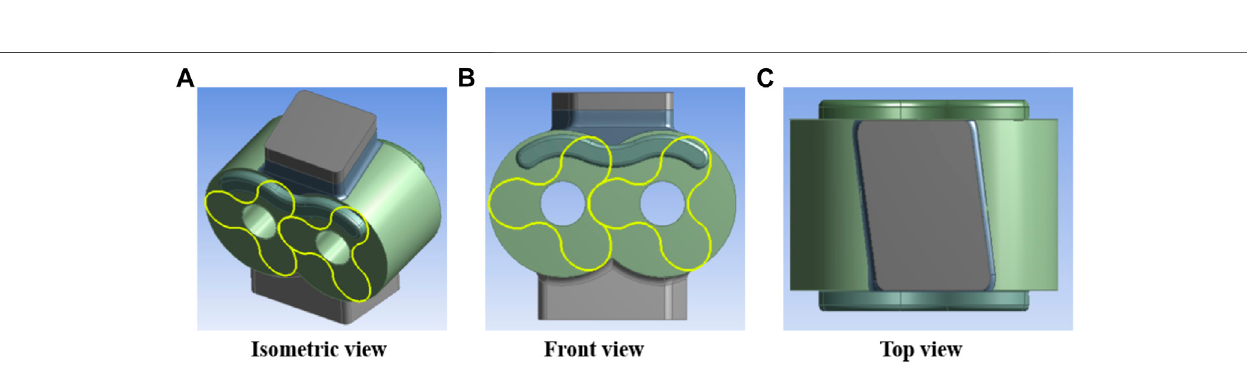
FIGURE 10 | Angled port design with two sides back fl ow